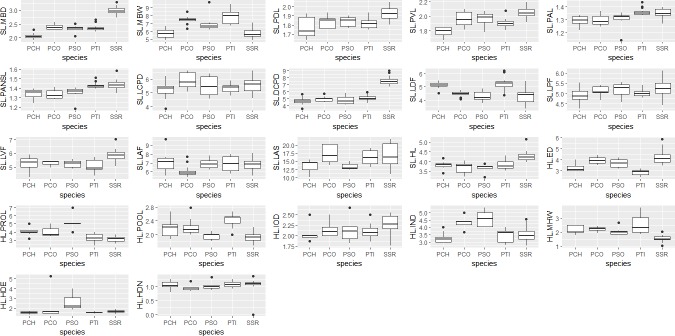
Boxplots of selected species based on morphometric characters: PCH (P. chola), PCO (P. conchonius), PSO (P. sophore), PTI (P. ticto), SSR (S. sarana) {SL: Standard length; MBD: Maximum body depth; MBW: Maximum body width; PDL: Pre-dorsal length; PVL: Pre-ventral length; PAL: Pre-anal length; PANSL: Pre-anus length; LCPD: Length of caudal peduncle; DCPD: Depth of caudal peduncle; LDF: Length of dorsal fin; LPF: Length of pectoral fin; LVF: Length of ventral fin; LAF: Length of anal fin; LPA: Length of pelvic axial; HL: Head length; ED: Eye diameter; PROL: Pre-orbital length; POOL: Post-orbital length; IOD: Inter-orbital distance; IND: Inter-narial distance; MHW: Maximum head width; HDE: Head depth at eye; HDN: Head depth at nape}.Fourteen characters were divided by SL, eight by HL, SL not shown.